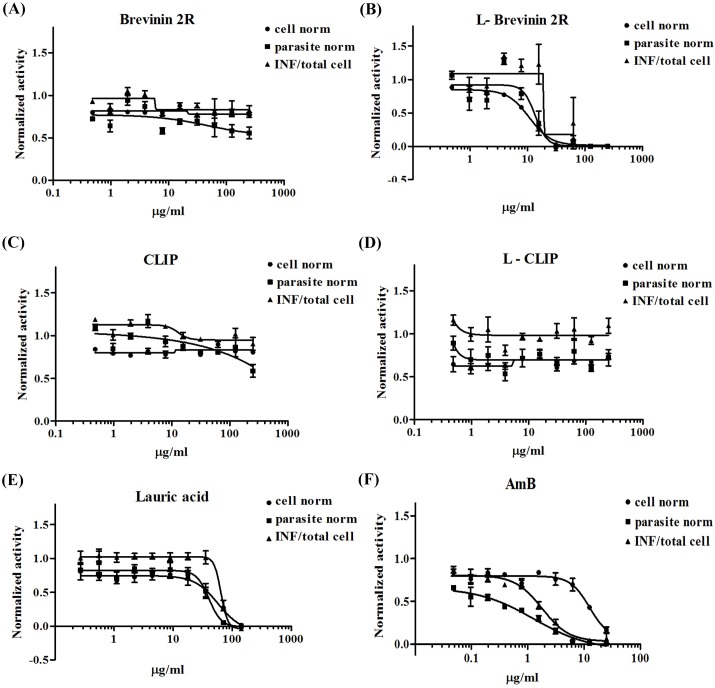
Effect of (A) Brevinin 2R, (B) L-Brevinin 2R, (C) CLIP, (D) L-CLIP, (E) Lauric acid, and (F) AmB on L. major amastigote growth and their toxicity effect on THP1 cells. Internalized promastigotes were transformed to amastigote in THP1 cells. Imaging system captured different views of the cells exposed to different concentrations of peptides. Eventually the ratio of infected to total THP1 cells (INF ratio), number of parasites presented inside the cells and number of THP1 cells were calculated.